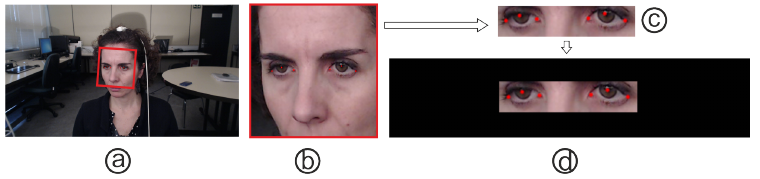
Figure 3. Image preprocessing used in the real environment experiments. The images ( a ) are rotated ( b ) so that the eyes are in the same line and cropped to the bounding box ( c ), which contains as meaningful information as possible. Then, a padding process ( d ) assures that all images have the same size before feeding them to the network. Images from the I2Head database [32].